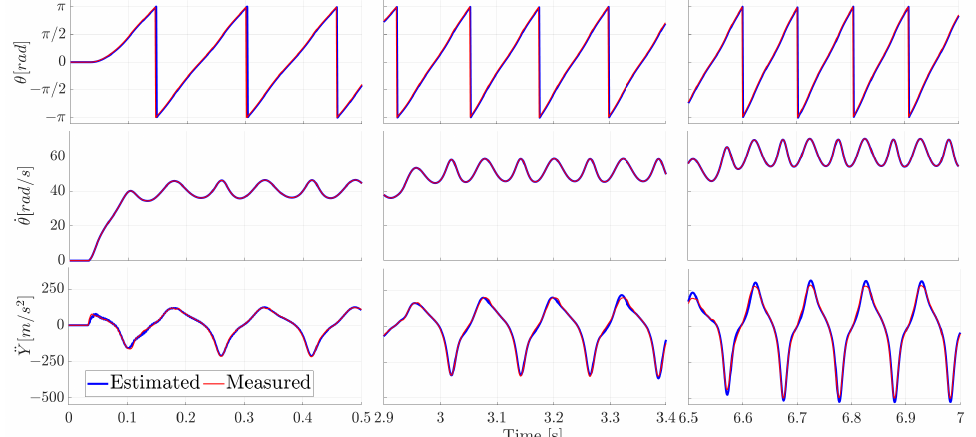
Figure 7. Comparison of the measured and estimated motor angle θ ( top row ), motor angular velocity ˙ θ ( middle row ) and translational slider acceleration ¨ Y ( bottom row ). Zoom-in per column on the velocity transitions.